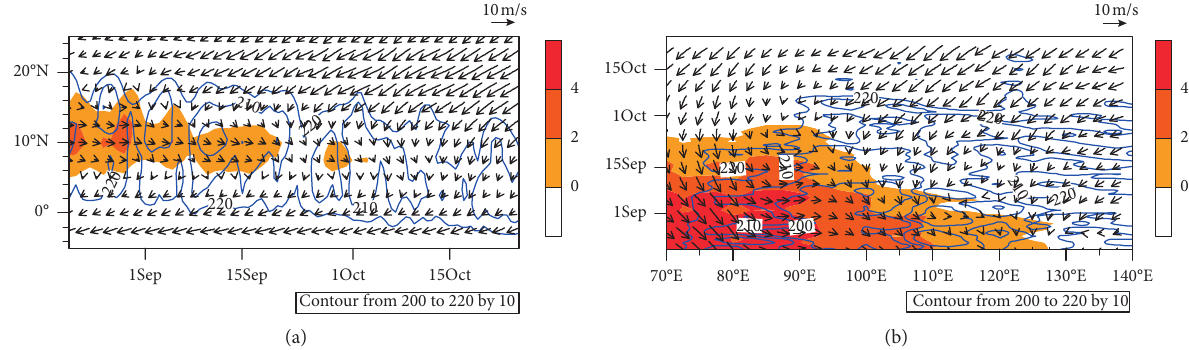
Figure 4: Latitude-time diagram of climatological 850hPa wind (vector, m/s), southwesterly wind (shading, m/s), and OLR (contour, W/ m 2 ) (a) between 110 ° E and 120 ° E and (b) between 10 ° N and 20 ° N. The vector unit is 10 m/s and the shading and contour interval is 10W/m 2 .